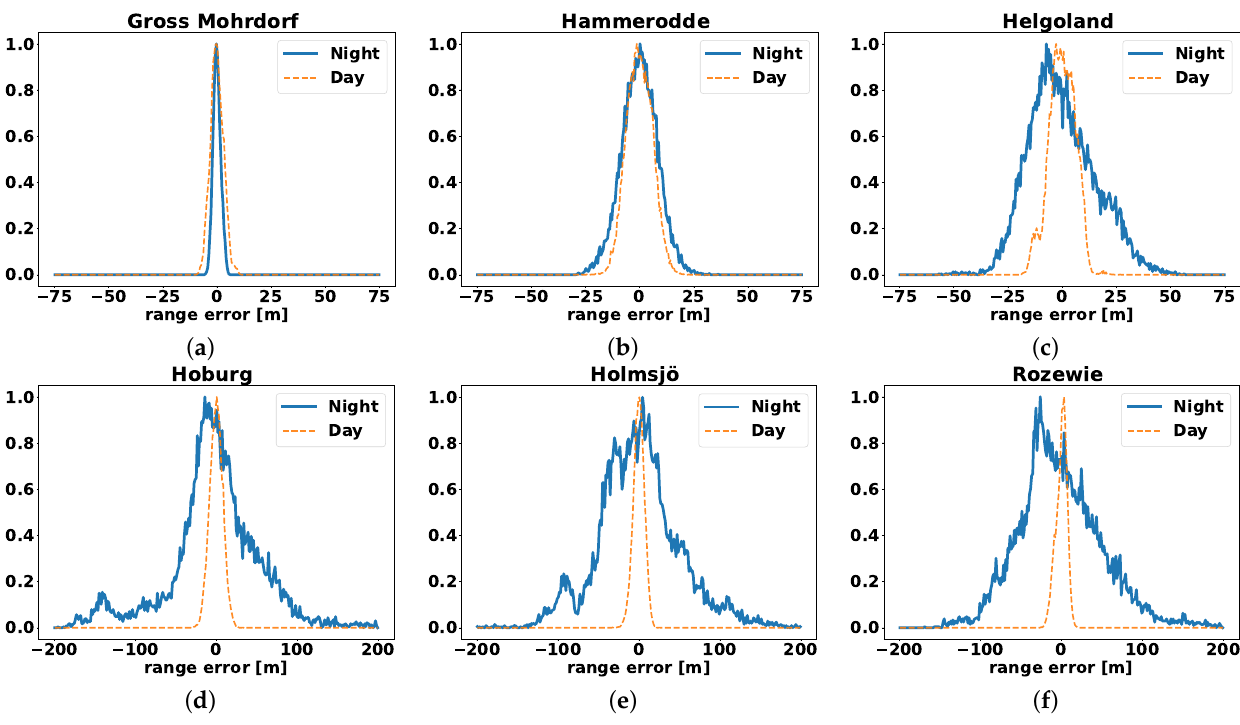
Figure 9. Normalized range error distribution for the CW1 signal. Solid blue line represents night- time data, while orange dashed line represents daytime data. ( a ) Groß Mohrdorf. ( b ) Hammerodde. ( c ) Helgoland. ( d ) Hoburg. ( e ) Holmsjö. ( f )